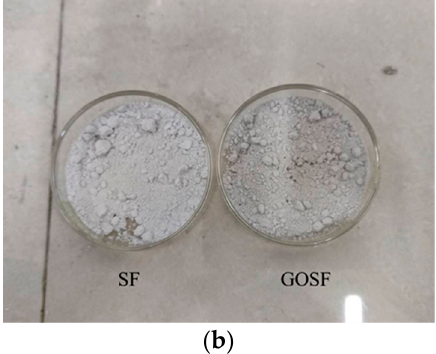
Figure 2. ( a ) The preparation principle of GOSF; ( b ) SF and GOSF powder.